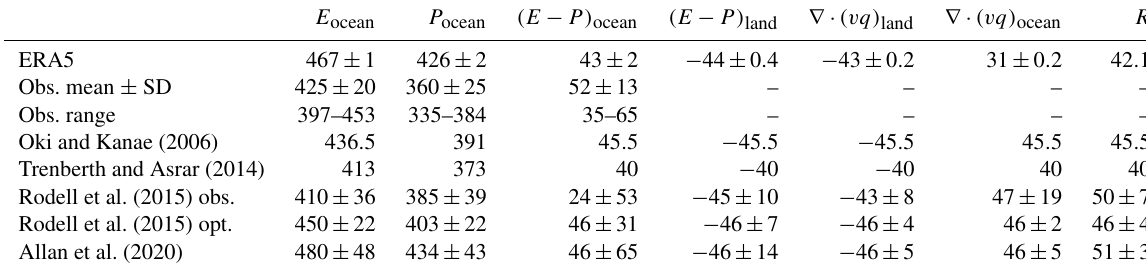
Table 4. Estimates of ocean total E and P , land and ocean total E − P , net transport of water vapor, and continental runoff given in 10 3 km 3 yr − 1 . The upper three rows contain results from this study, and the lower five those from earlier investigations. ERA5 estimates are calculated from ensemble mean data; the standard deviation (SD) is derived from ensemble statistics. The satellite-based data sets used in our study were averaged to obtain the mean and SD of observed (Obs.) E ocean and P ocean , and the range is given in the third row. Net water vapor flux divergence over land ( ∇ · (vq) land ) and ocean ( ∇ · (vq) ocean ) and continental runoff R are given in the last three columns. The estimates from the study by Rodell et al. (2015) are separated into observations (obs.) and model-optimized observations (opt.); see the text for